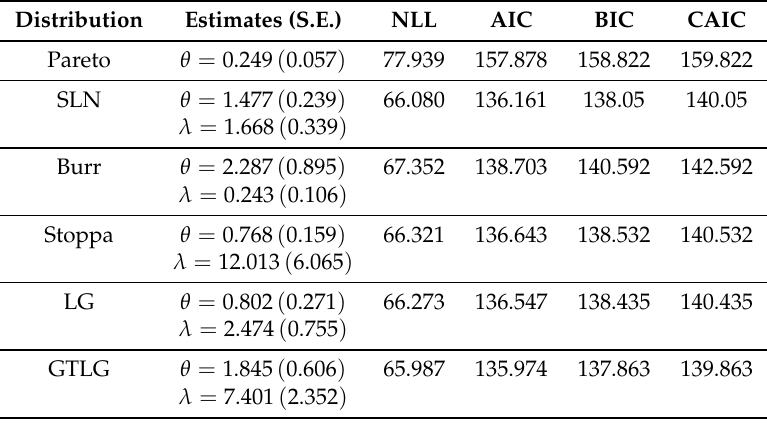
Table 1. Estimated values of the considered models when α =